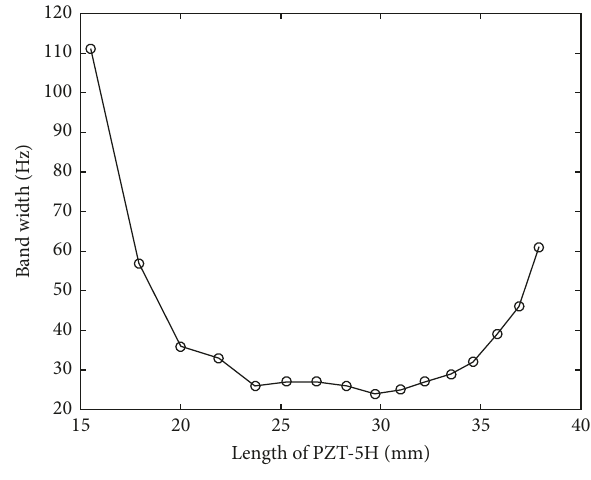
Figure 12: The bandwidth vs. the length of PZT-5H.